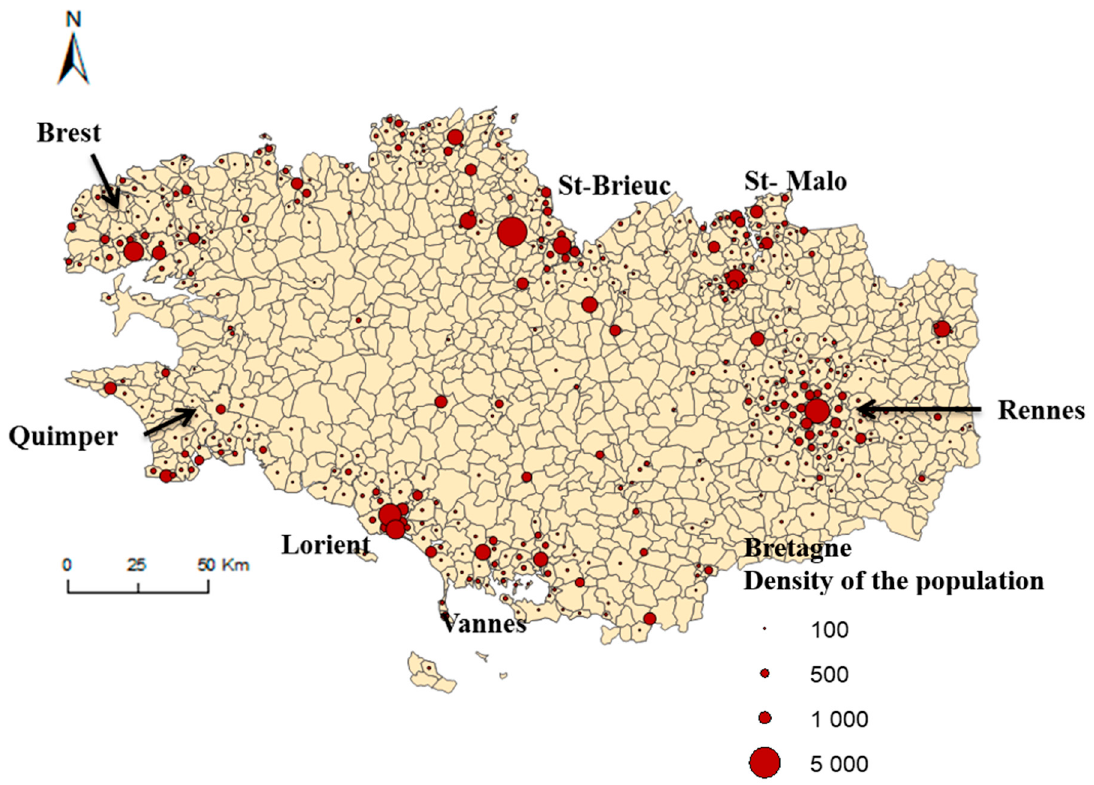
Figure 1. Major cities in Bretagne. Geographic representation of the density of the population by municipalities.